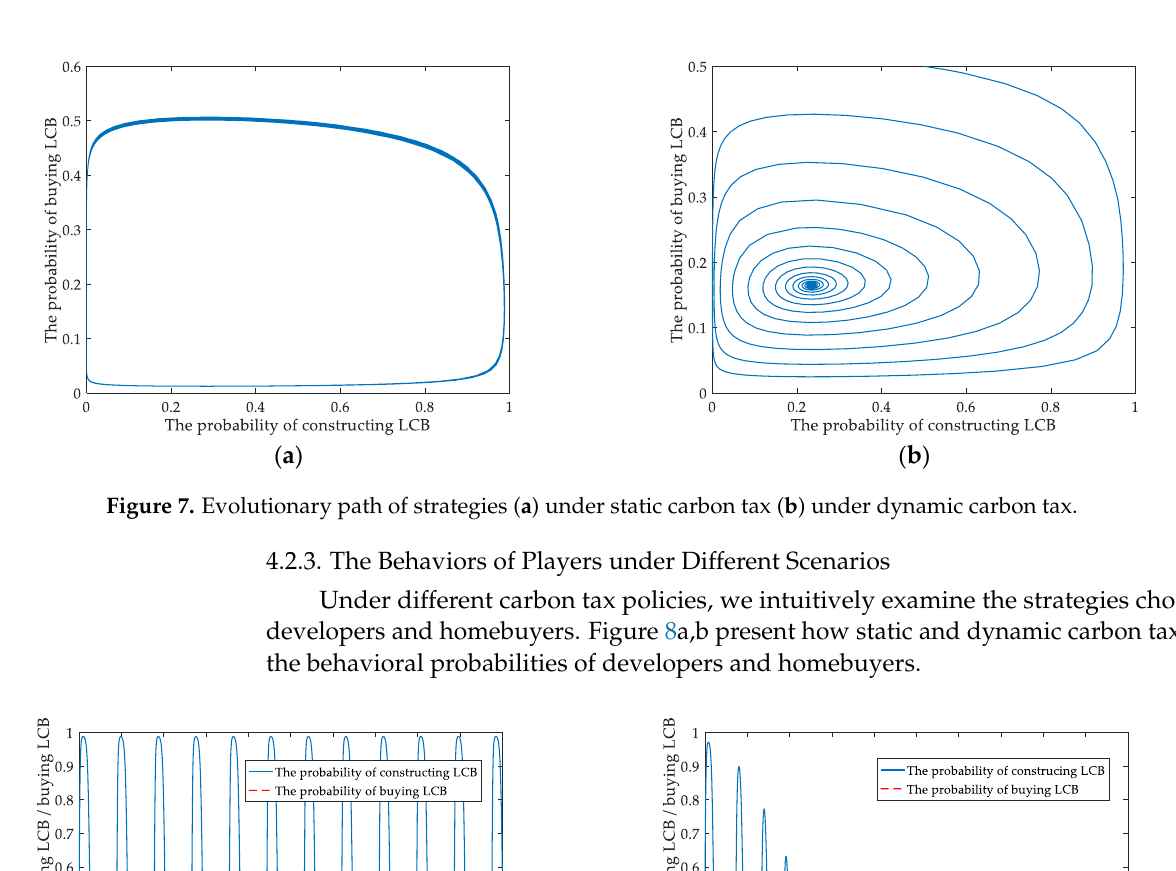
Figure 7. Evolutionary path of strategies ( a ) under static carbon tax ( b ) under dynamic carbon tax.